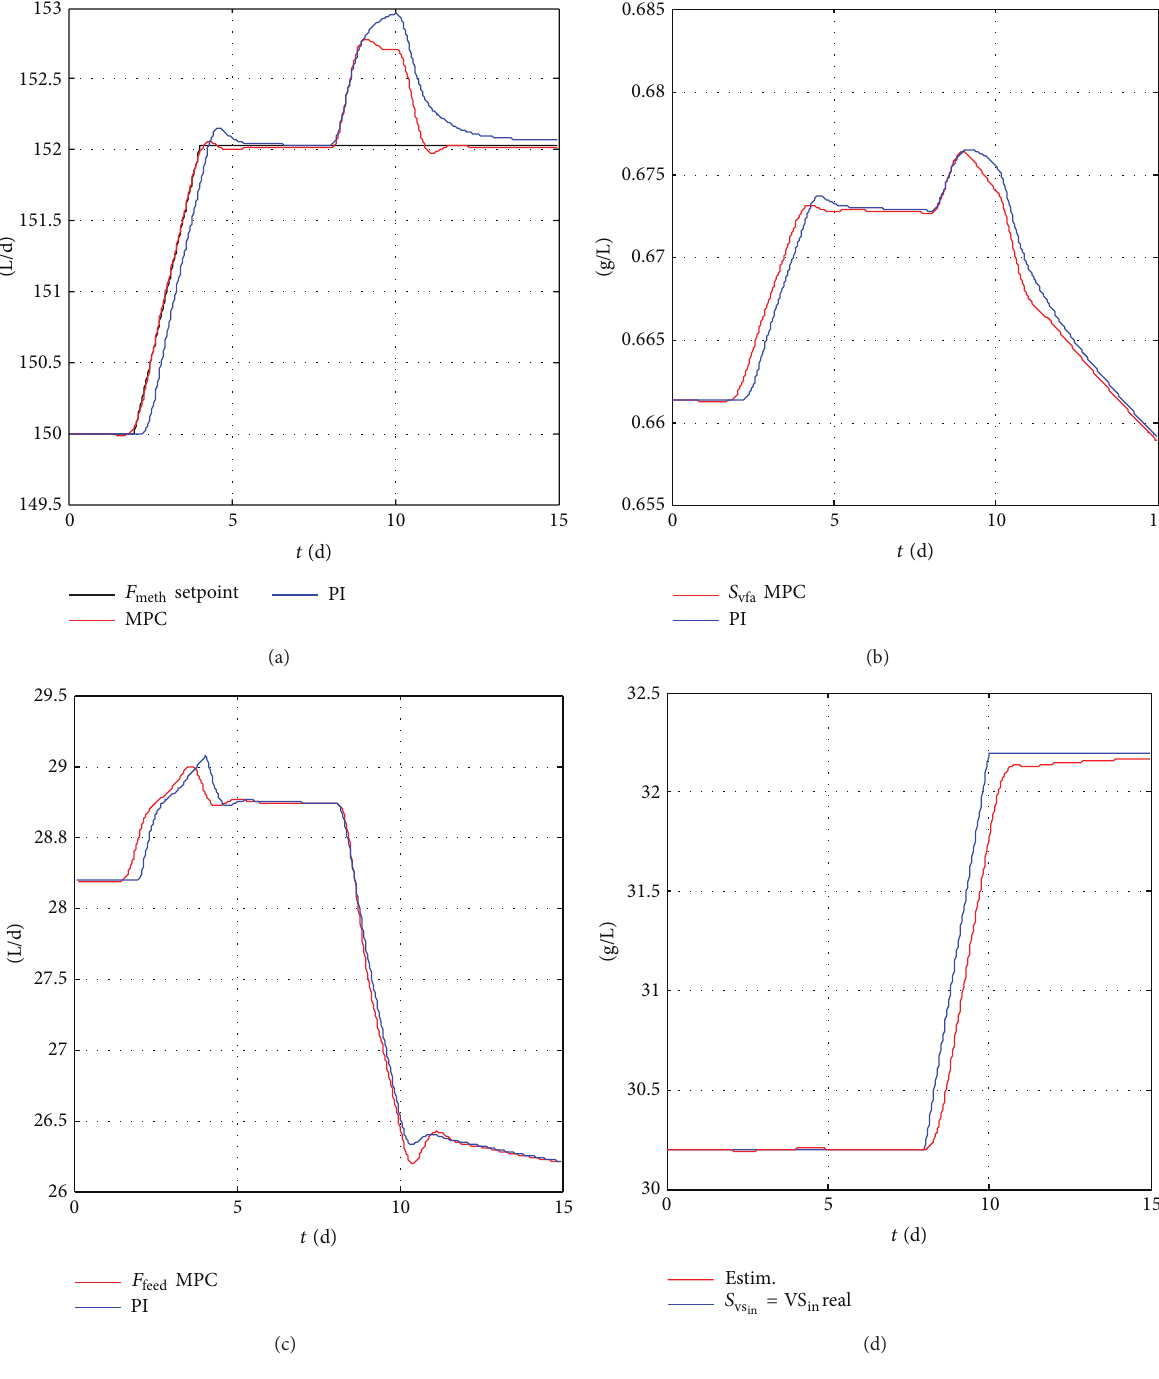
Figure 7: Simulated responses with predictive control and PI